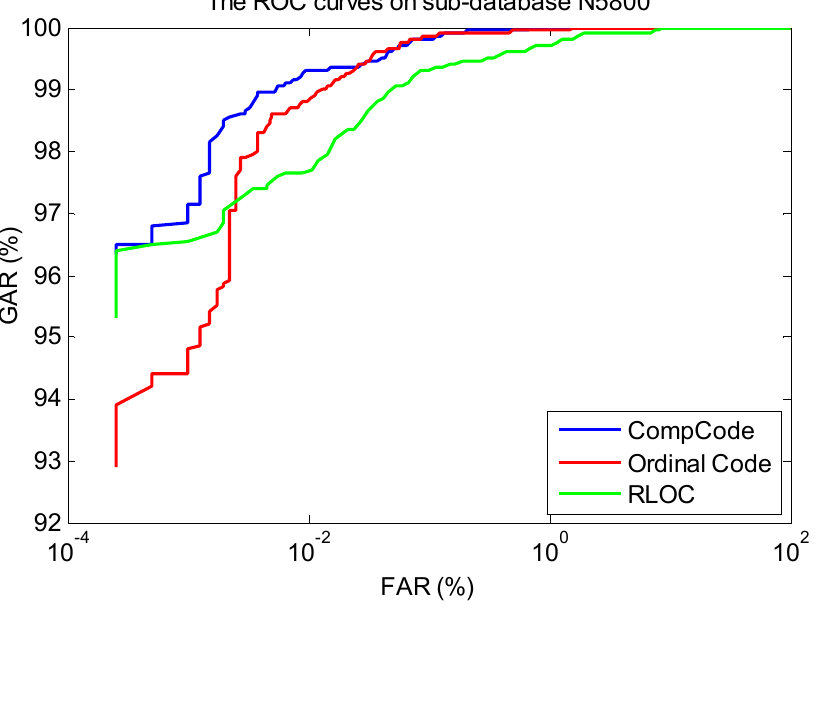
in BLPOC method achieved highest 1